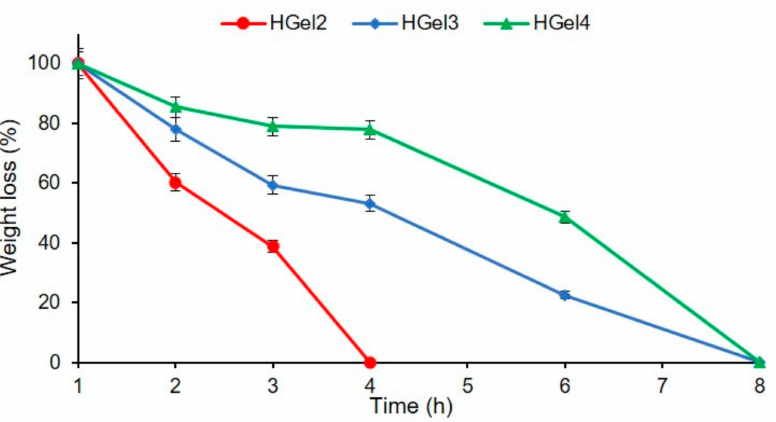
Figure 5. Enzymatic degradation of gelatin-based hydrogels in the presence of 0.1 mg/mL of collagenase, at 37 ◦ C. Means ± SD, n =